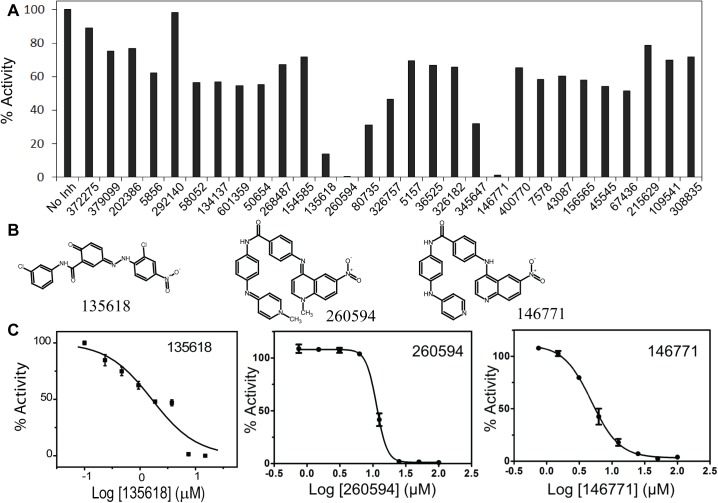
Inhibition of in vitro NS2B-NS3pro activity by compounds identified by VS.(A) Compounds identified by VS were added to an in vitro protease activity assay at a concentration of 100 μM and protease activity relative to the DMSO control was measured. No inhibitor (No Inh) was set as 100%. The protease activities with compounds were set as percentage of the No Inh control. (B) Schematic formulas of selected compounds showing in vitro anti-protease activities. (C) Concentration curves of in vitro protease activity inhibition by compounds NSC135618, 20594, and 146771. Compounds were incubated with the linked DENV2 NS2B-NS3 protease (150 nM) for 30 min, prior to addition of the Abz substrate (100 μM). Two fold dilutions of 135618 (from 15 μM to 0.23 μM), 260594 (from 100 μM to 1.6 μM), and 146771 (from 100 μM to 1.6 μM) were used. The protease activity of the DMSO control was set as 100%. The protease activities with compounds were set as percentage of the DMSO control. Data was fitted using the Sigmoidal model within the Origin6.0 software suite.